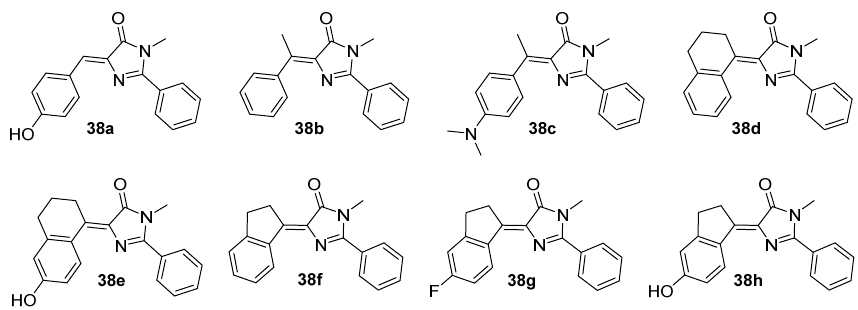
Figure 34. GFPc analogues with isomerization restricted by a cyclic pattern [51].